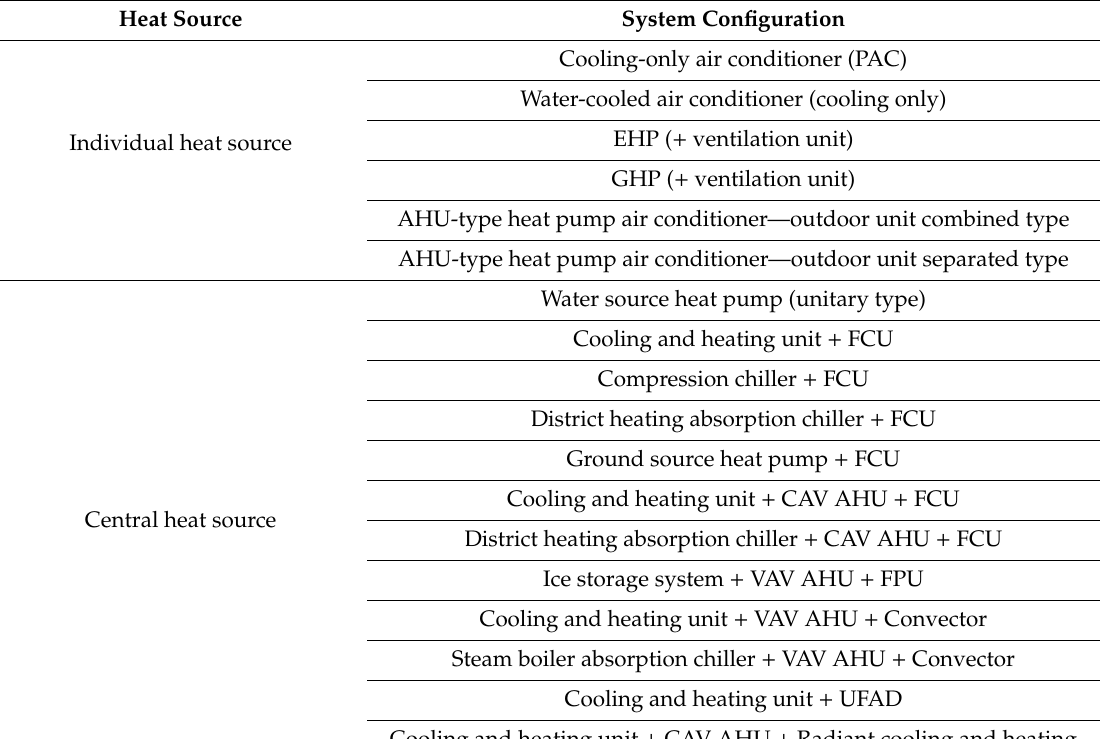
Table A2. Examples of space cooling systems.